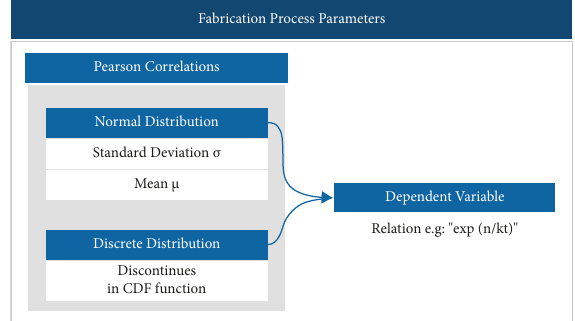
Figure 1: Proposed scheme of variables representation and cor- relations between